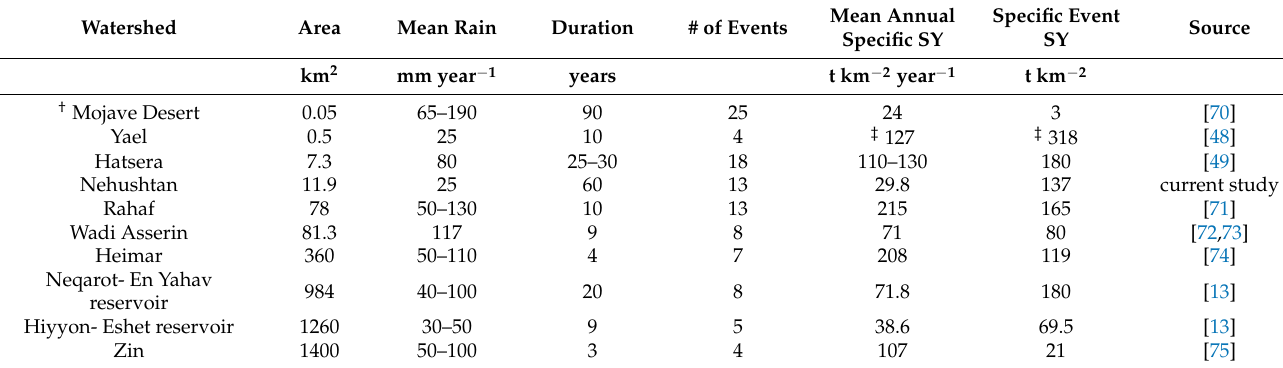
Table 2. Sediment yield (SY) of select watersheds in arid